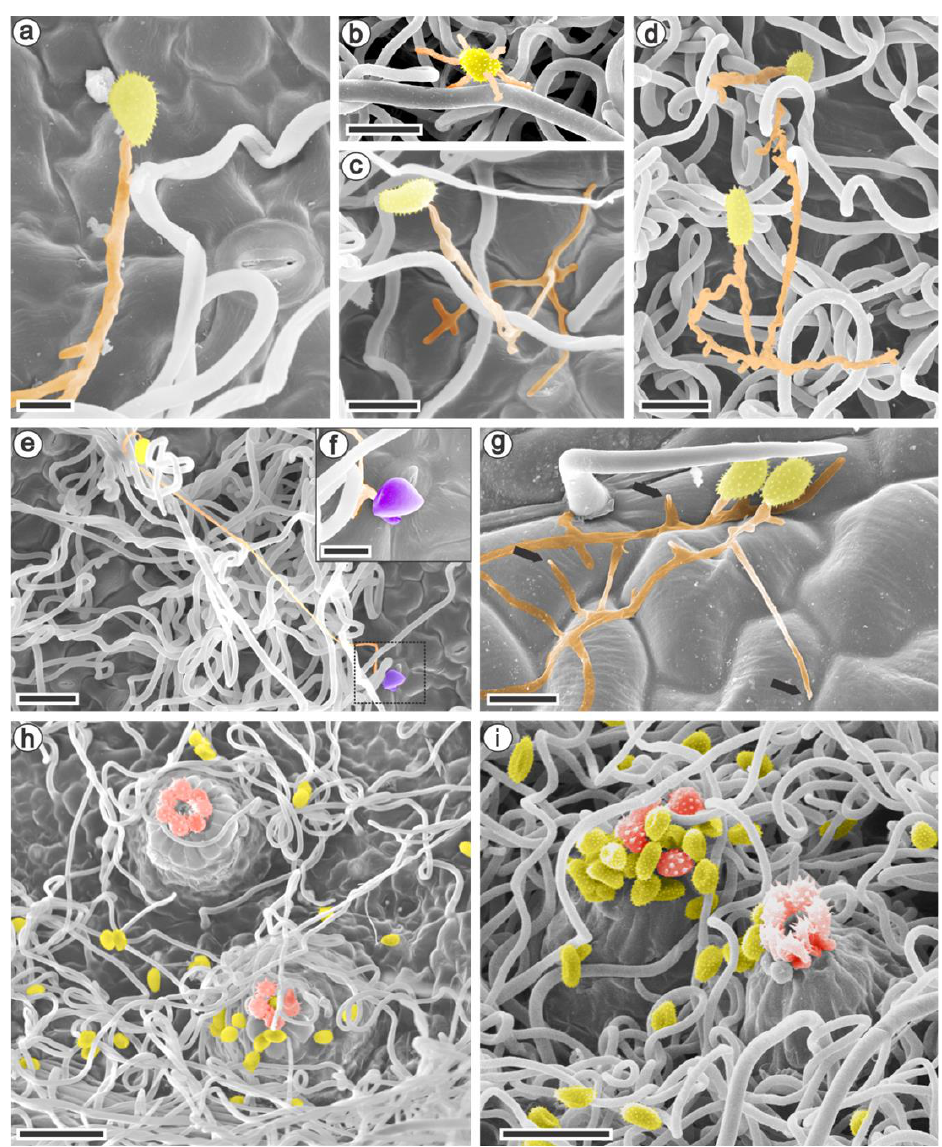
Figure 2. Scanning electron micrographs of the adaxial ( g ) and abaxial leaf surfaces ( a – f , h – i ) of Rubus idaeus cv. Autumn Bliss ( c , e , f , h ), R. occidentalis ( a , b , g , i ), and R. niveus ( d ) at 6 ( a ), 12 ( b ), 24 ( g ), 36 ( c – f ) hours, and 14 ( h – i ) days after inoculation with Aculeastrum americanum . ( a , b ) Urediniospores emitting one ( a ) or several ( b ) germ tubes. ( c ) Branched germ tube. ( d ) Urediniospores germinated on the trichomes in R. niveus . ( e ) Appressorium formed over a stoma (dotted box) showed in detail in (f). ( g ) Germinated urediniospores without the formation of an appressorium at the end of the germ tubes (arrows). ( h , i ) Satellite uredia with ostiolar cells that delimit the opening through which the urediniospores are released. A. americanum structures were artificially stained using Adobe Photoshop 2020 ® . Urediniospore, yellow; germ tube, orange; appressorium, purple; uredia ostiolar cells, red. Bars: ( a , f ): 10 µ m; ( b – d , g ): 20 µ m; ( e ): 30 µ m; ( h – i ): 50 µ